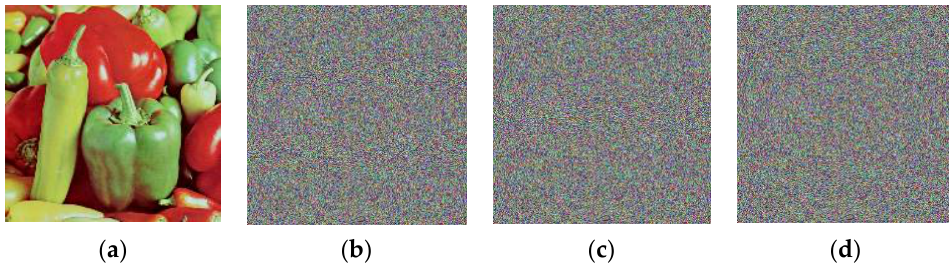
Figure 15. Key sensitivity analysis: ( a ) the correct key; ( b ) x 0 is 0.6715 + 10 −14 ; ( c ) b 0 is 0.7391 + 10 −14 ; ( d ) c 0 is 0.4183 + 10 −14 .